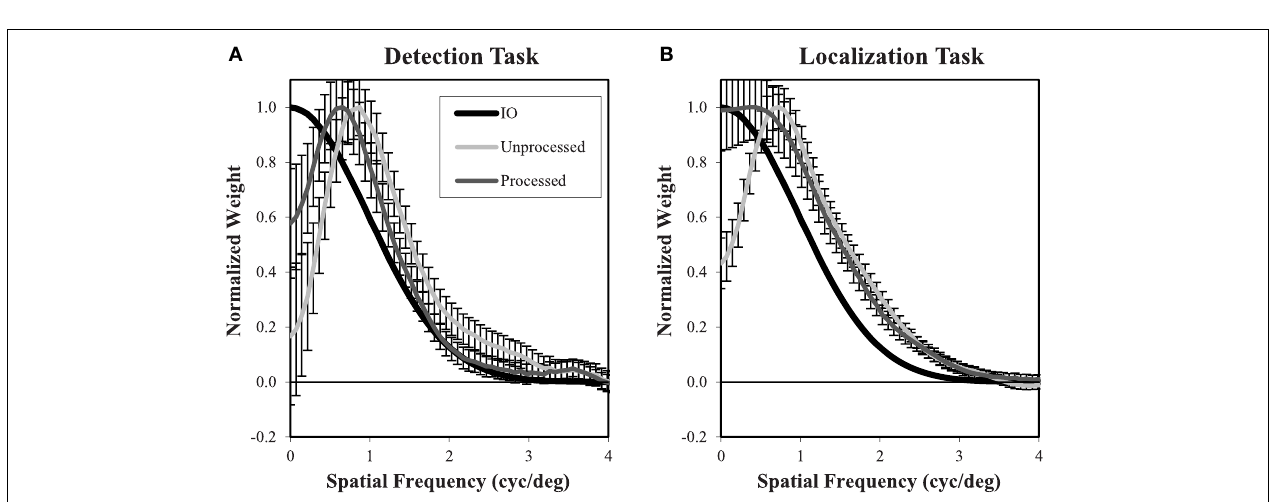
The ideal observer profile is derived from theory. The detection and localization plots are averaged across the five subjects. Error bars are ± 1 s.e. averaged across subjects. The legend (A) applies to all plots.